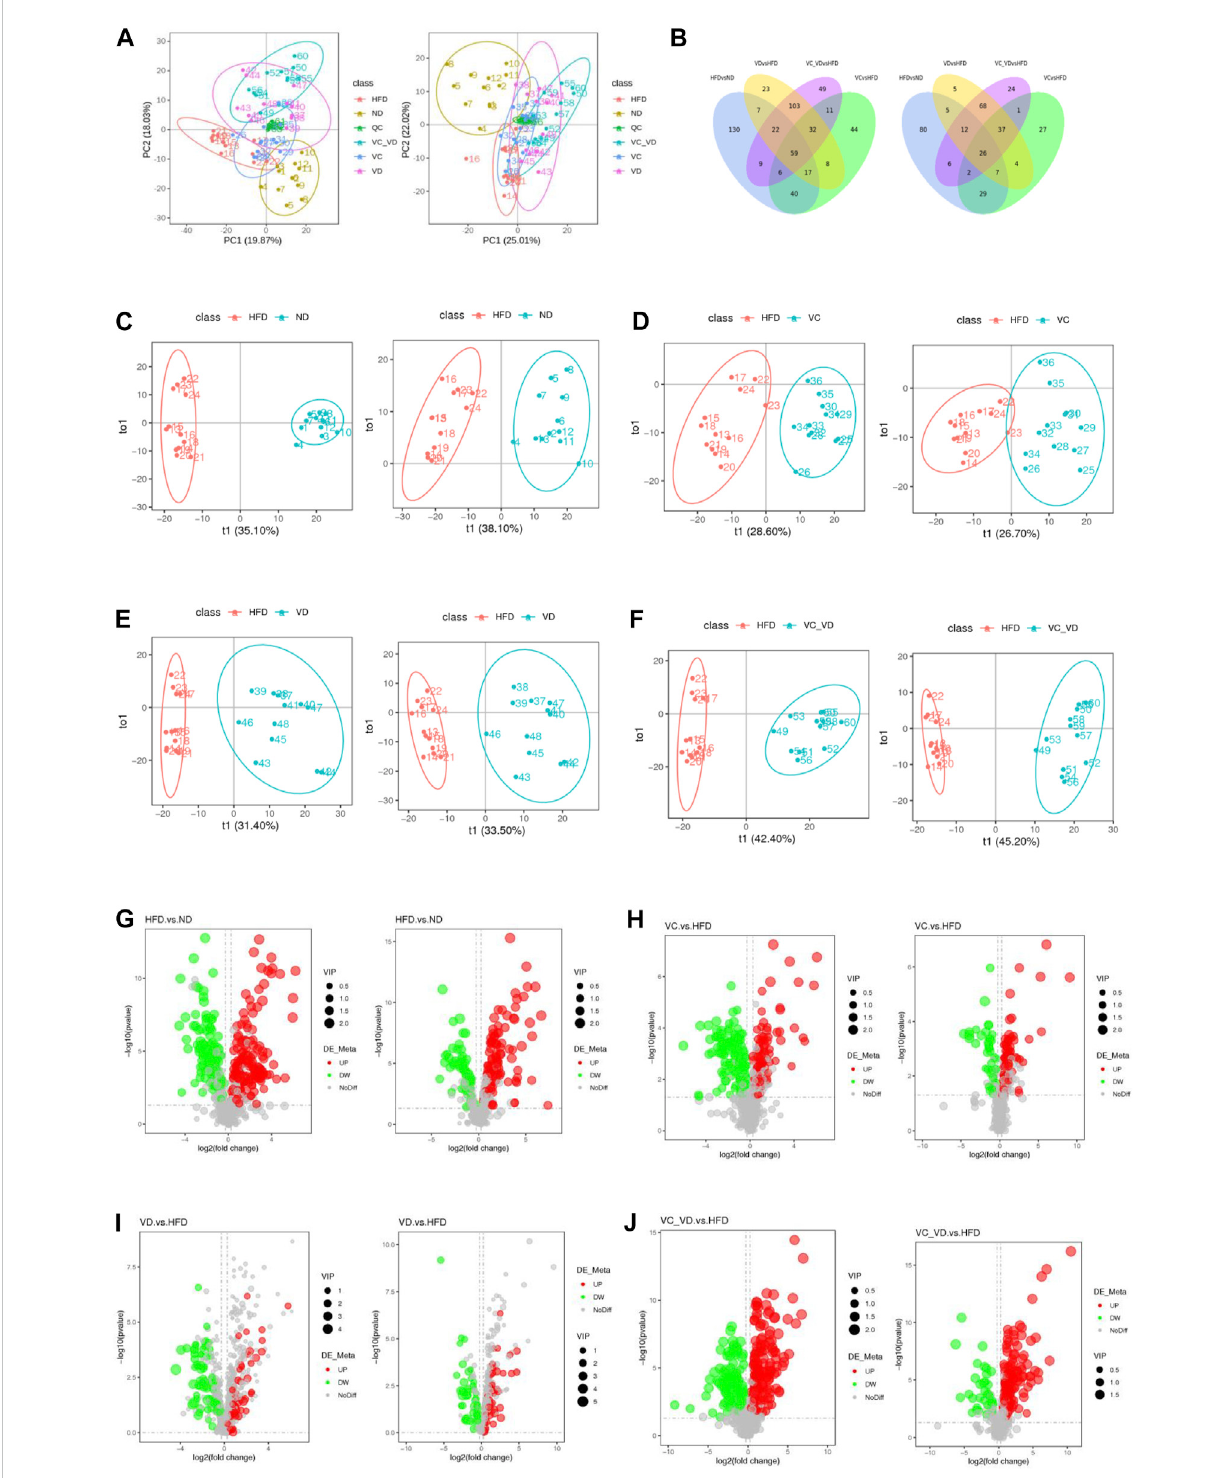
FIGURE 6 EffectofVCandVD 3 onlivermetabolomicpro fi linginobesemice. (A) PCAscoreplotsofthedifferentgroupsinpositivepolarity(left)andnegativepolarity (right) modes. The quality control (QC) sample was prepared by mixing equal volumes of all the samples. (B) Venn diagrams displaying the number of differentially abundantmetabolites that overlapped in the HFDvs. ND, VC vs. HFD, VD vs. HFD, and VC + VD vs.HFD comparisons in positivepolarity (left) and negativepolarity(right)modes. (C) OPLS-DAscoreplotsoftheHFDandNDgroupsinpositivepolarity(left)andnegativepolarity(right)modes. (D) OPLS- DA score plots of the HFD and VC groups in positive polarity (left) and negative polarity (right) modes. (E) OPLS-DA score plots of the HFD and VD groups in positivepolarity(left)andnegativepolarity(right)modes. (F) OPLS-DAscoreplotsoftheHFDandVC+VDgroupsinpositivepolarity(left)andnegativepolarity (right)modes. (G) VolcanoplotsshowingthedysregulatedfeaturesbetweentheHFDandNDgroupsinpositivepolarity(left)andnegativepolarity(right)modes. (H) VolcanoplotsfortheVCandHFDgroupsinpositivepolarity(left)andnegativepolarity(right)modes. (I) VolcanoplotsfortheVDandHFDgroupsinpositive polarity(left)andnegativepolarity(right)modes. (J) VolcanoplotsfortheVC+